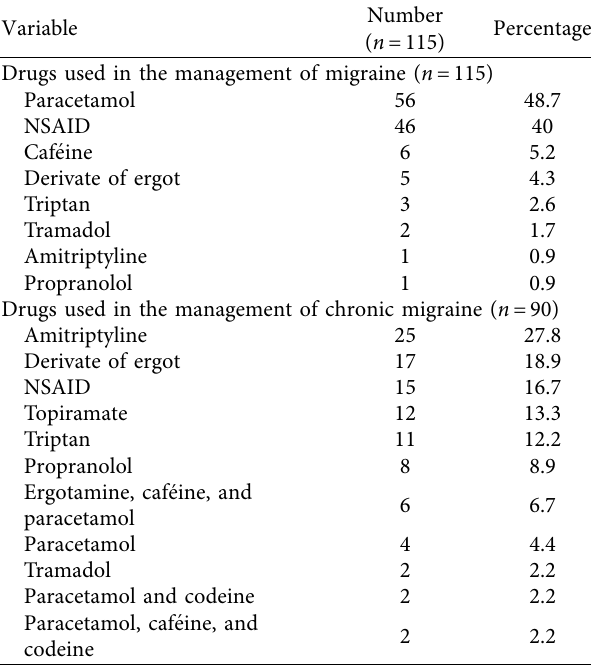
Table 3: Drugs used by GPs in the management of acute and chronic